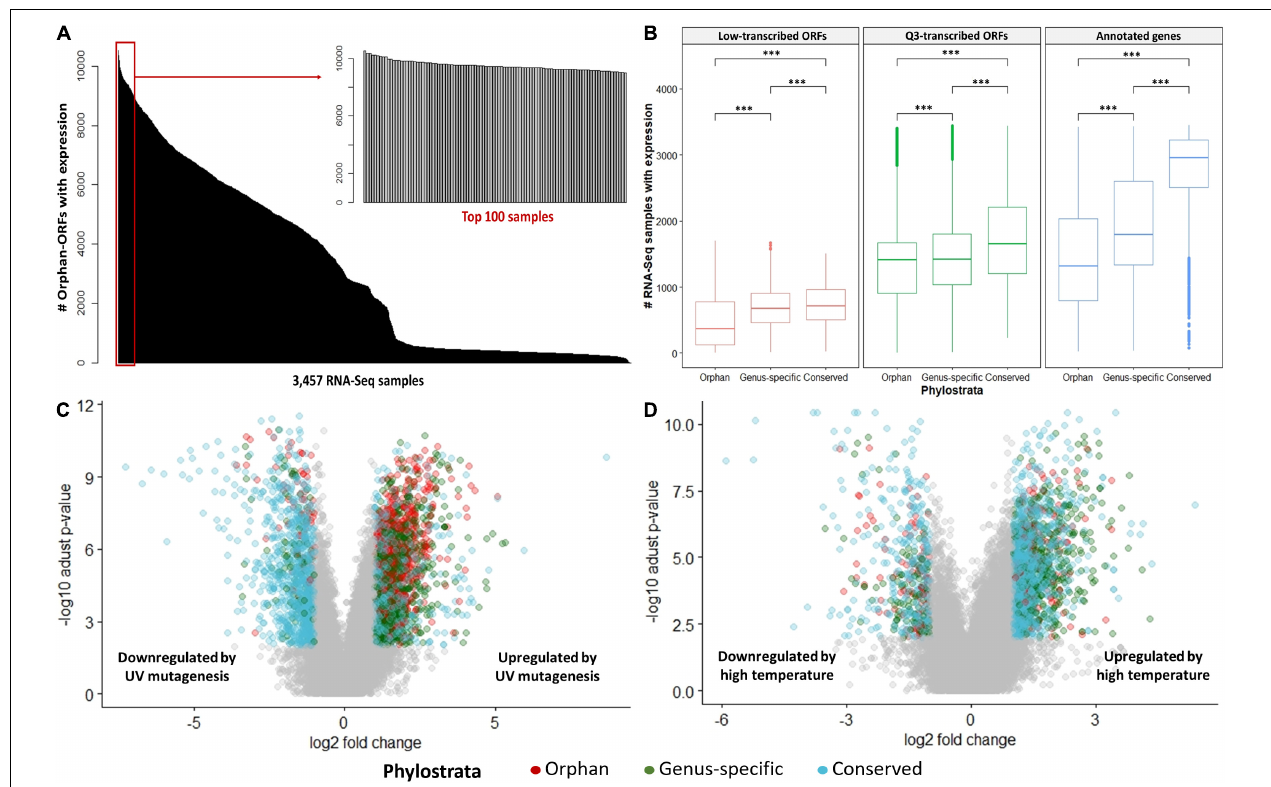
FIGURE 3 | RNA-Seq expression by conditions. (A) Number of orphan- ORFs with expression evidence in each RNA-Seq sample. The black bars show distribution of the counts of the 15,809 orphan-ORFs. X -axis, 3,457 RNA-Seq samples, sorted by counts. The gray bar inset details the top 100 RNA-Seq samples with the largest number of orphan-ORFs. (B) Number of RNA-Seq samples in which gene/ORF is expressed. ∗∗∗ , p -value < 0.001 according to t -test. (C,D) Volcano plot for differential analysis under UV mutagenesis and high temperature. X -axis, log2 fold change of mean expression under control and stress conditions. Y -axis, -log10 of adjusted p -value in Mann–Whitney U test. Differentially expressed genes/ORFs are colored according to phylostrata, and gray points indicates unregulated by stress.